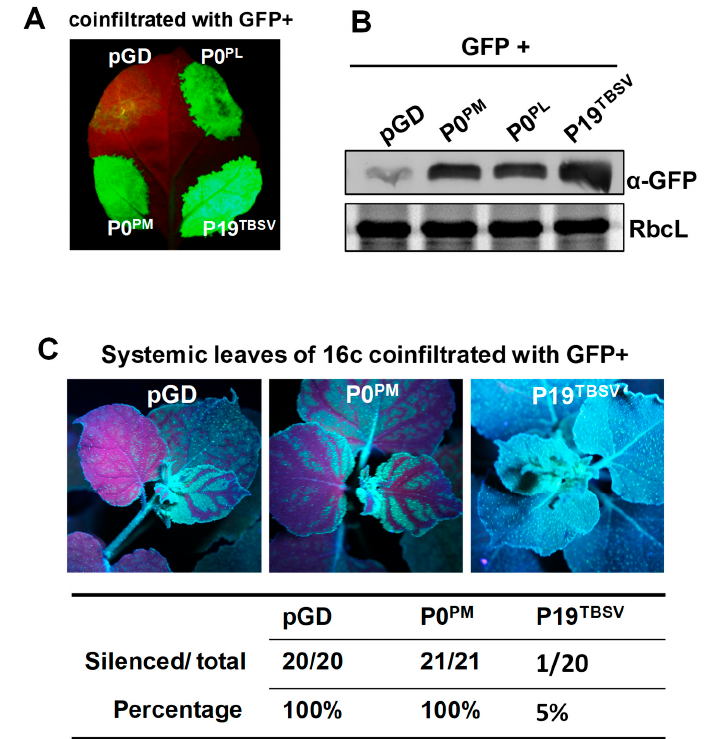
Figure 1. P0 PM protein suppressed local but not systemic RNA silencing. ( A ) Agroinfiltration of N. benthamiana leaves with green fluorescent protein (GFP) plus empty vector pGD, P0 PL , P19 TBSV , or P0 PM . The empty vector pGD was used as negative control. P0 PL and P19 TBSV were used as positive controls. Photographs were taken under long-wavelength UV light at 5 days post-infiltration (dpi). ( B ) GFP proteins from infiltrated leaf patches were detected by Western blotting. GFP was detected with GFP polyclonal antiserum. RbcL is the Rubisco large subunit. ( C ) Systemic RNA silencing suppression activity of P0 PM . GFP was transiently co-expressed in leaves of GFP transgenic N. benthamiana 16c plants with pGD, P0 PM , or P19 TBSV . The empty vector pGD and P19 TBSV were used as negative and positive controls, respectively. Photographs of the upper leaves were taken under long-wavelength UV light at 14 dpi. The ratios below the images show the number of systemic silencing plants out of the total number of infiltrated plants. The systemic silencing e ffi ciency was scored in three independent